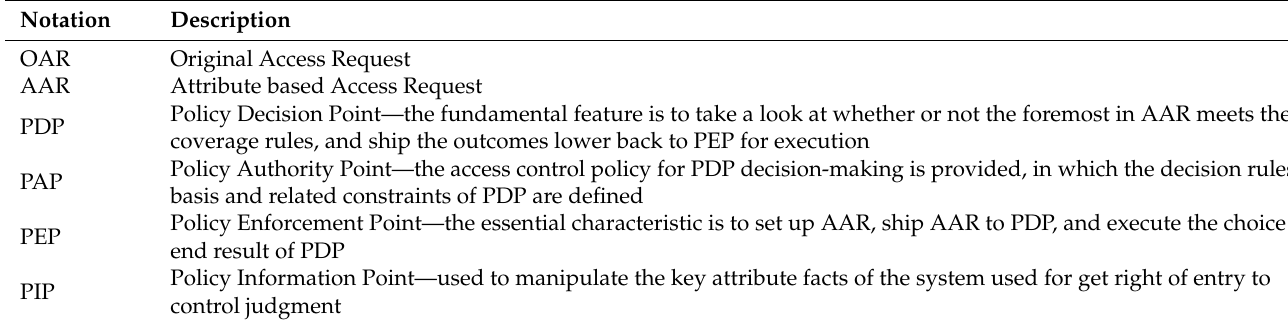
Table 1. Notation and Description involved in ABAC